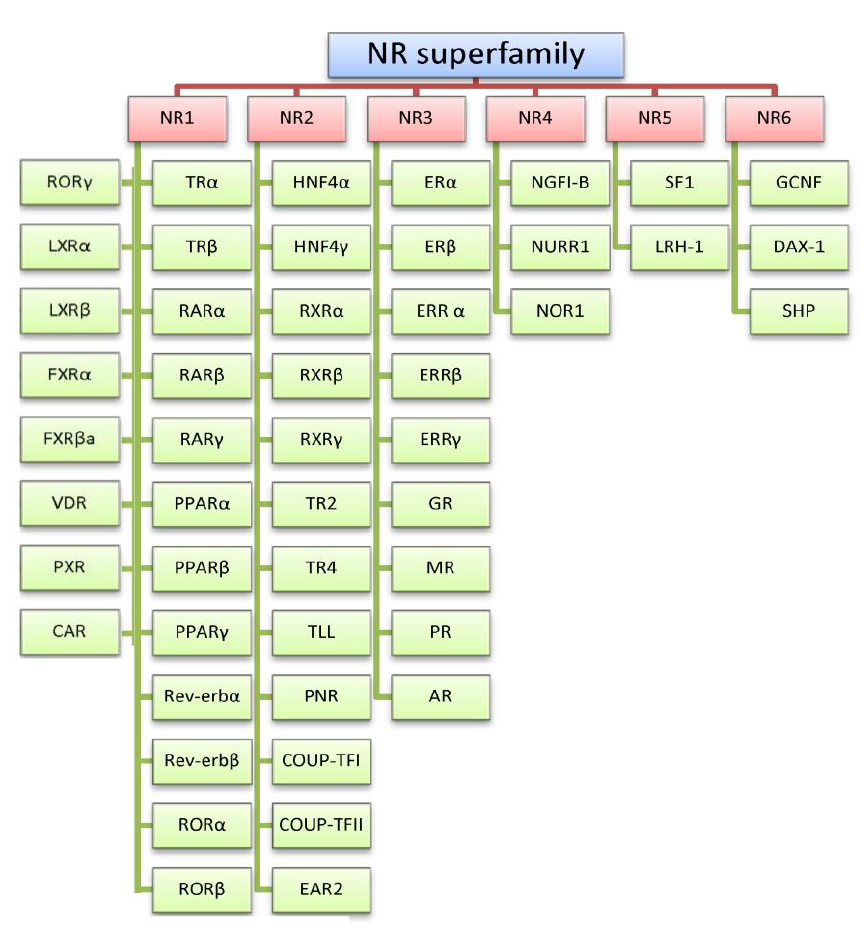
Figure 1. Taxonomy of the nuclear receptor (NR) superfamily and members of the families 1-6